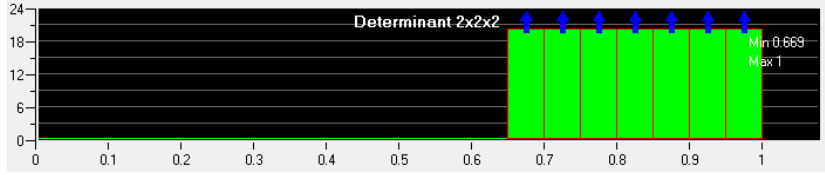
Figure 2. Hexahedral mesh of ( a ) entire computational domain and ( b ) shock tube.